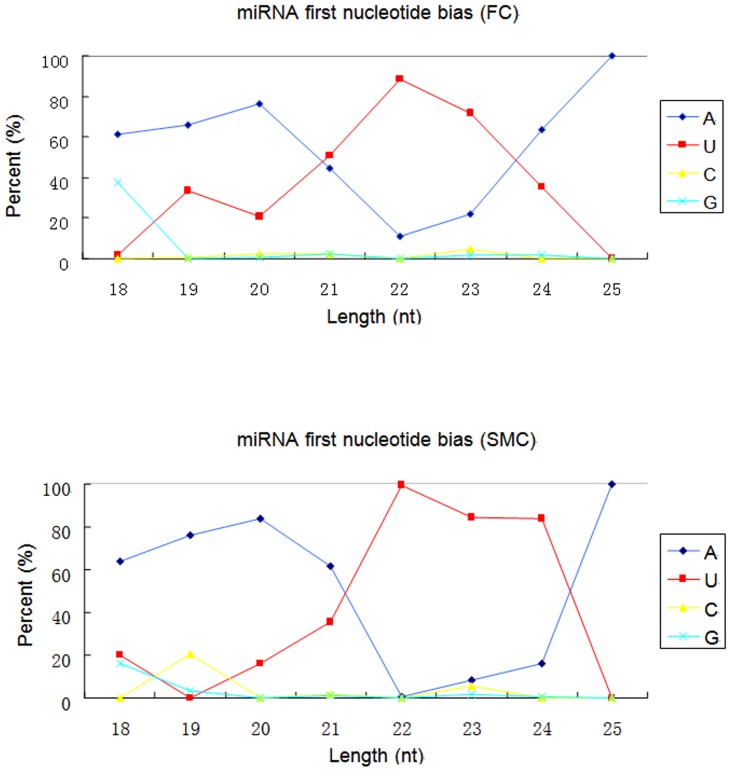
Nucleotide bias of the first base in different sequence lengths.First nucleotide bias in different sequence lengths from 18–25 nt for known miRNAs; SMC: six month-old caprine muscle tissue; FC: fetal caprine muscle tissue.